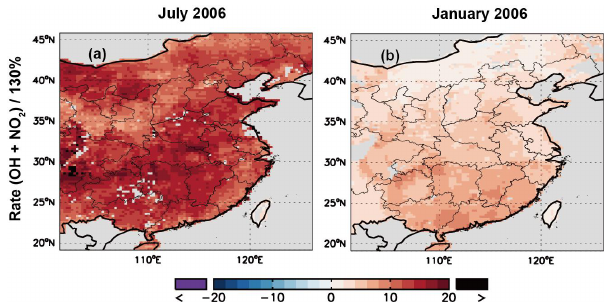
Fig. 7. Spatial distribution of percentage differences between mod- eled NO 2 columns with and without scaling down the rate constant of OH + NO 2 reaction by a factor of